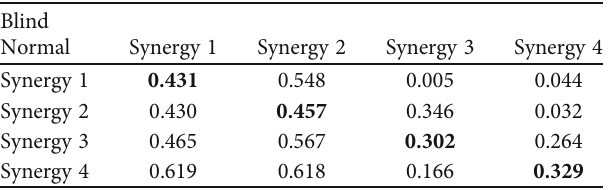
Bold values signify the correlation between two